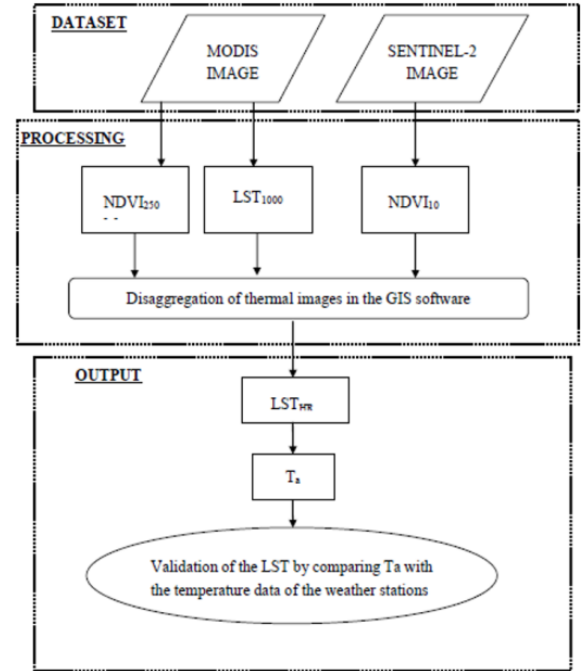
Figure 2. Flowchart of the methodology used.